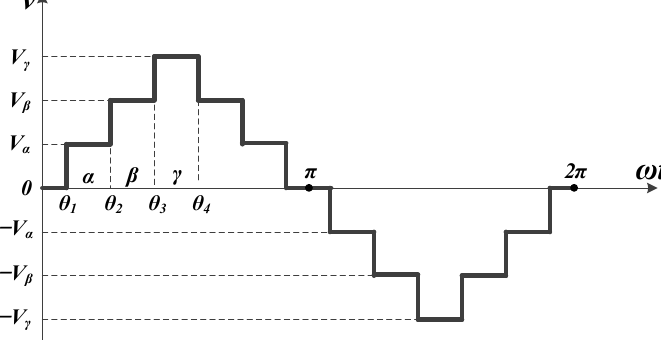
Figure 2. Seven-level AC waveform with specified angles for RMS calculation.